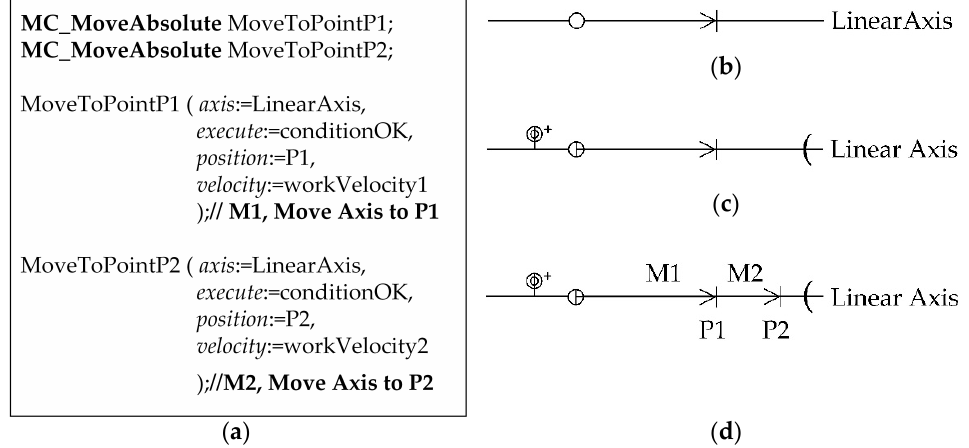
Figure 7. Stages for the graphic representation of the motion program. ( a ) Program in PLCopen with the motion commands of two absolute positioning of a servo axis. ( b ) Basic representation. ( c ) Limits are added and the origin of the axis coordinate system (ACS) is indicated. ( d ) Representation of two movements.